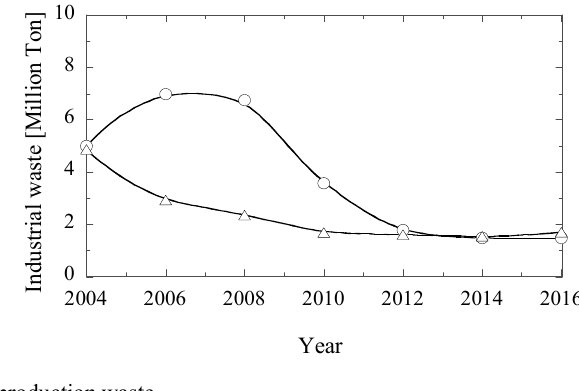
Figure 1. Annual amounts of wastes generated by pulp and paper industries and by metal industries in Sweden [2].